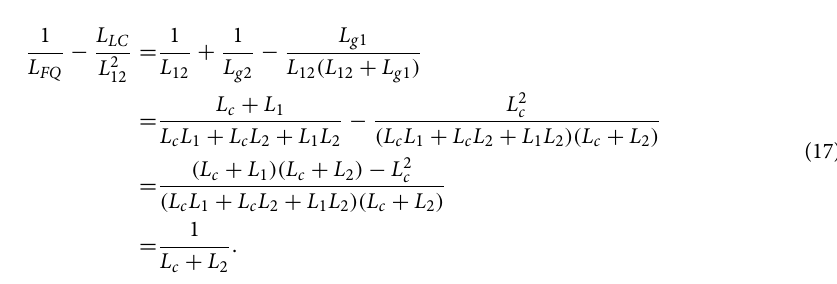
Figure 7. Expectation values of photon number, flux, and current operators for ( a – d ) ˆ H circ and for ( e , f ) ˆ H ′ circ . ( a , e ) Expectation numbers of photons in the oscillator in the ground state as a function of L c . The solid curve H 1 / (cid:31) 0 0 0.5 , while the dashed line in panel ( a ) indicates the simple /( 1 / √ L LC C ) corresponds to ˆ − (cid:30) (cid:30) ω . ( b , f ) [ d , h ] Expectation values of fluxes 2 π (cid:29) (cid:31) expression ( g /ω) 2 , which is valid in the limit � q (cid:30) (cid:30) ≪ (cid:30) (cid:30) I k ] as functions of the flux bias (cid:31) x in the case L c [Expectation values of currents ˆ 1 and 2, and solid and dashed lines indicate the ground and the excited states, colors respectively indicate k (cid:31) (cid:30) = � 1 /� 0 in the ground state as a function of L c at respectively. ( c , g ) Expectation value of flux 2 π ˆ 0.498 � x /� 0 (cid:31) (cid:30) =